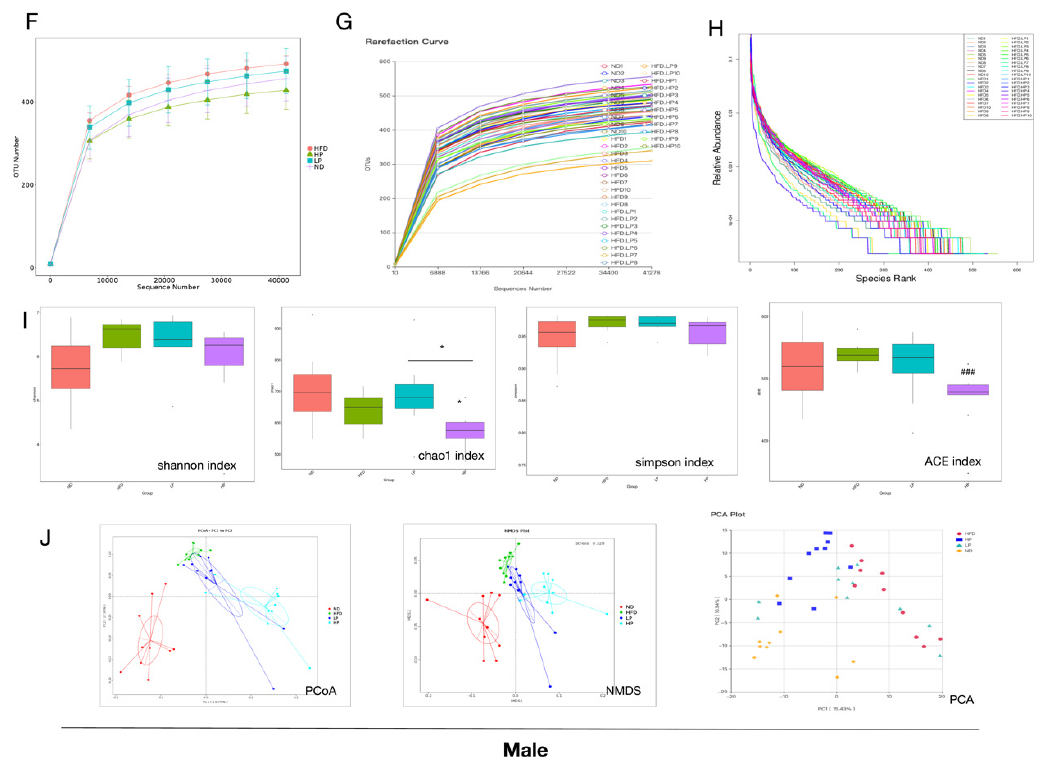
Figure 5. CP application altered microbial diversity and structure in HFD-fed mice. The operational taxonomic unit (OTU) rarefaction curve and the rank curve of microbial diversity responded to dietary change and CP treatment in female mice ( A – C ) and male mice ( F – H ). ( D , I ) show the Shannon, Chao1, Simpson and ACE indexes in both genders. ( E , J ) Principal coordinate analysis PCoA score plot based on a binary Jaccard, non-metric multidimensional scaling (NMDS) score plot based on an unweighted, and principal component analysis (PCA) score plot based on weights.